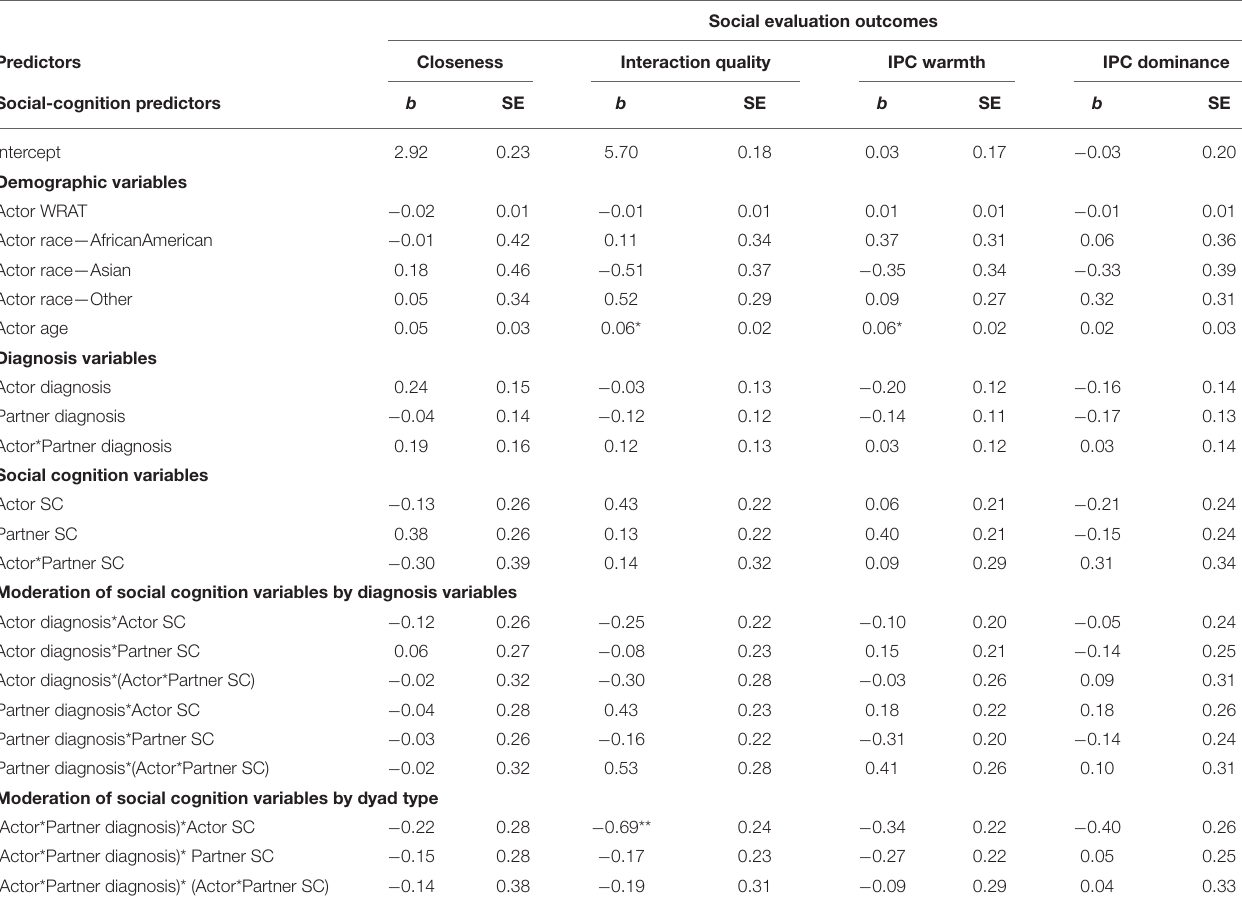
TABLE 7 | Actor-partner interdependence model analyses estimating the combinatorial effects of diagnostic status and social cognition variables on the social evaluation outcomes of closeness, interaction quality, warmth, and